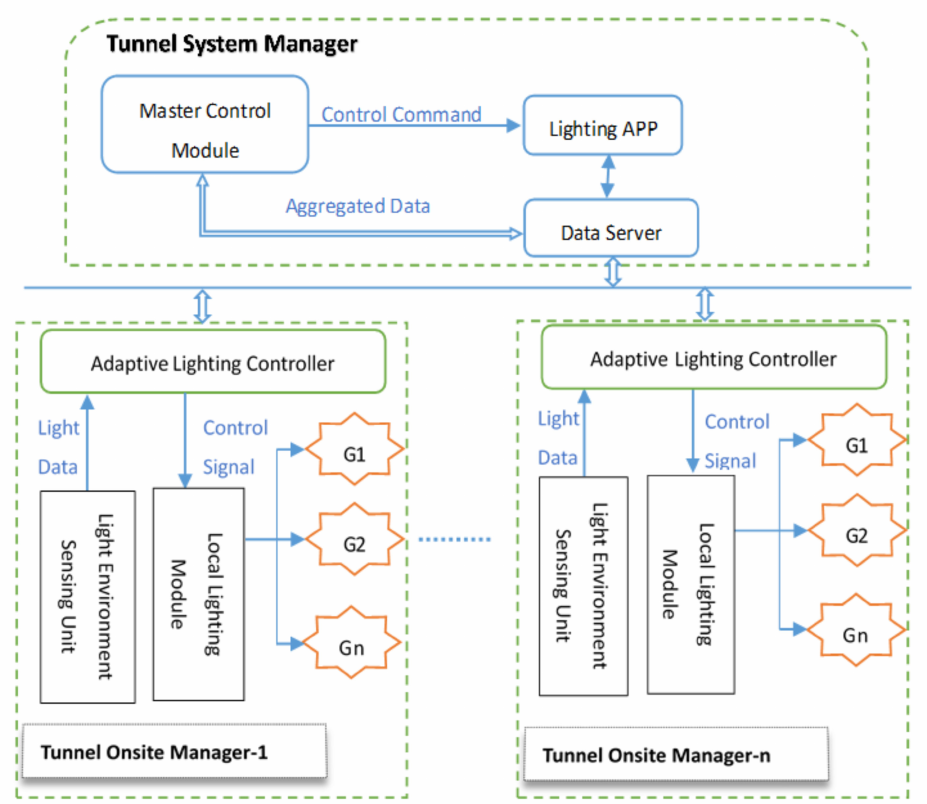
Figure 6. Network topology of the tunnel lighting control